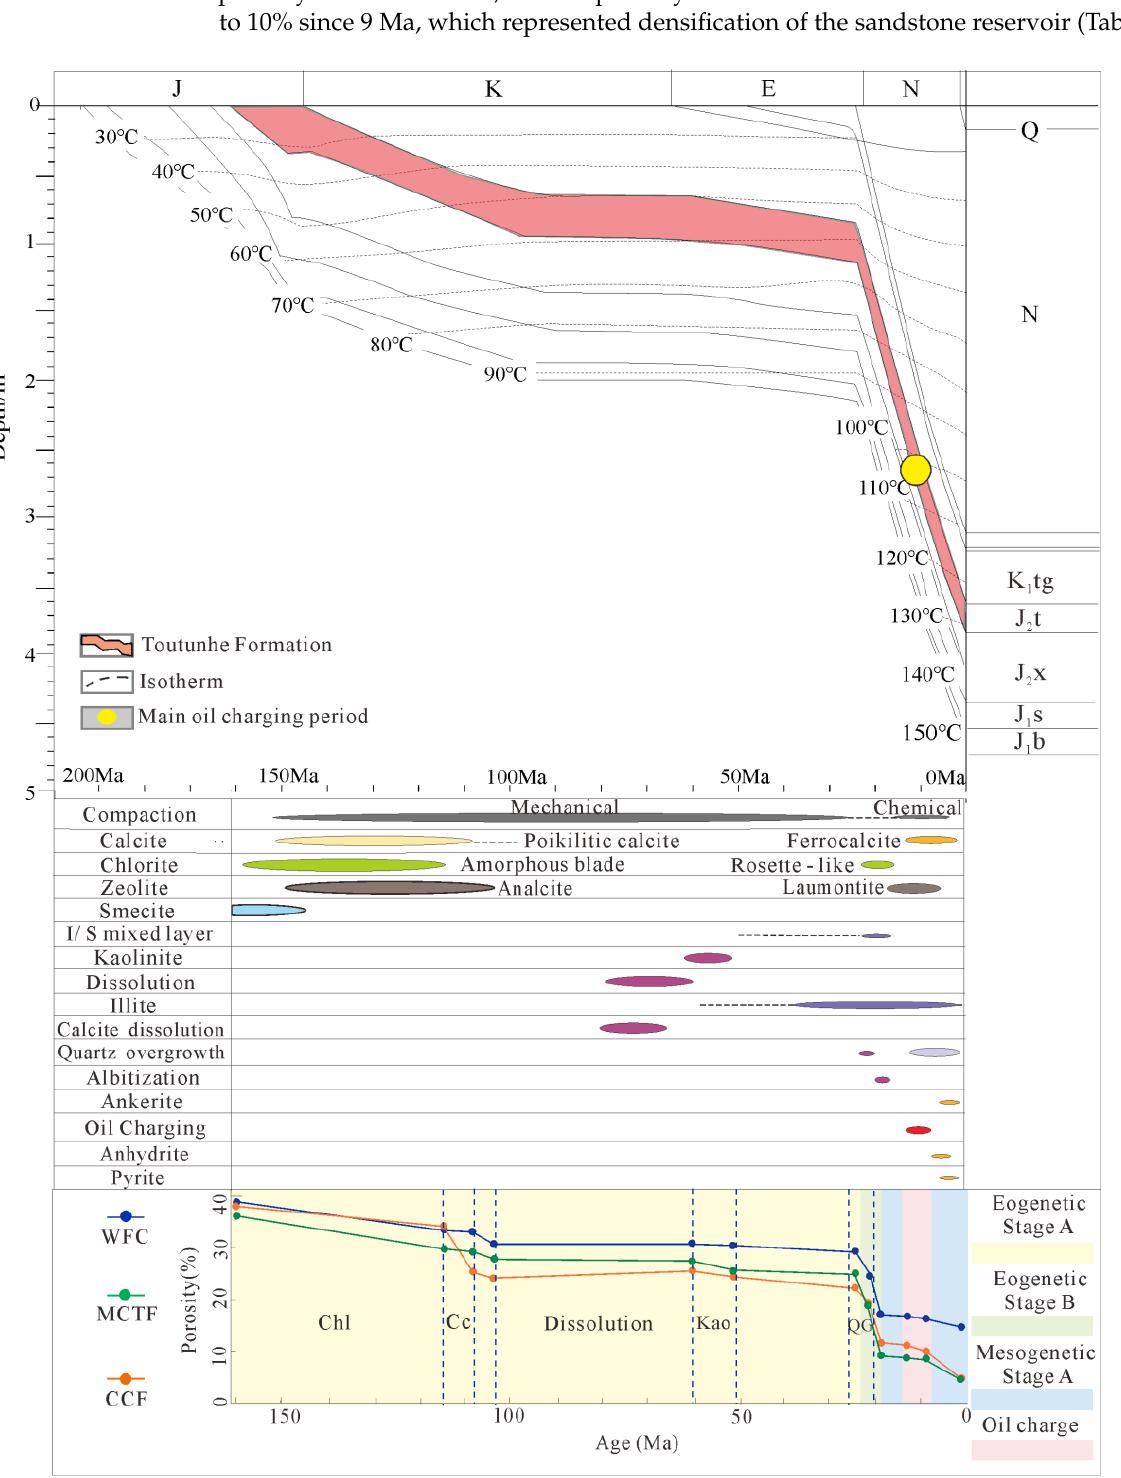
Figure 11. Diagenesis sequence and hydrocarbon charging timing of three lithofacies in the Toutunhe Formation. J: Juras- sic, K: Cretaceous, E: Paleogene, N: Neogene, K 1 tg: Tugulu Formation, J 2 t: Toutunhe Formation, J 2 x: Xishanyao Formation,